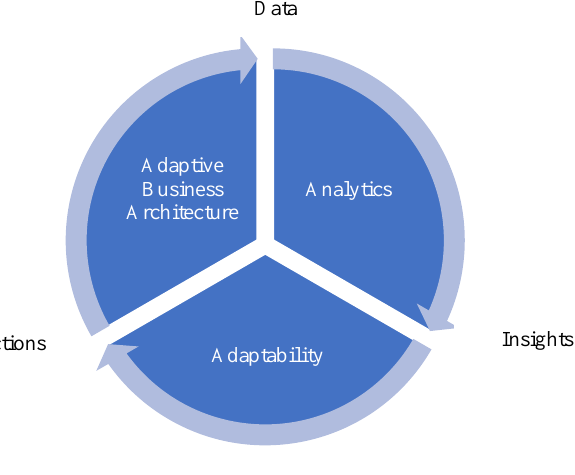
Figure 3. Business analytics-enabled